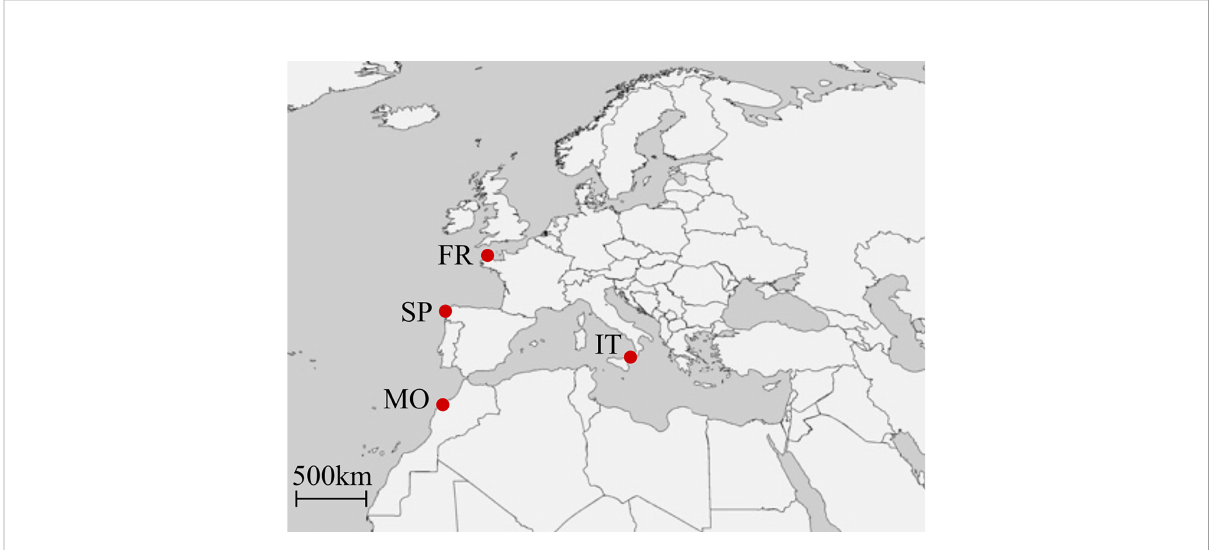
FIGURE 1 Sampling locations of Laminaria ochroleuca populations (red circles): France (FR), Italy (IT), Spain (SP) and Morocco